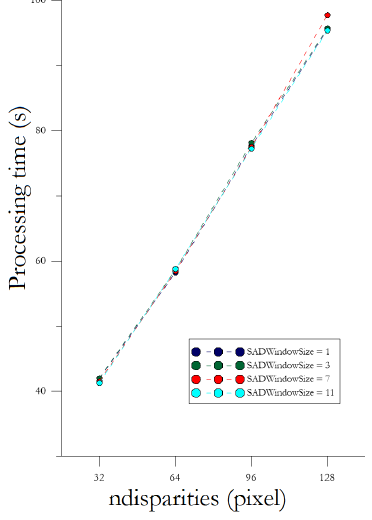
Figure 7: Processing time for optimal value of